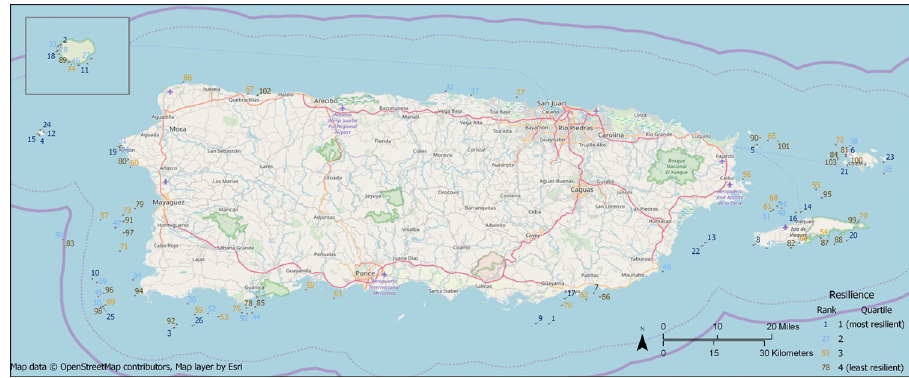
Fig 2. Survey sites (n = 103) with resilience rank scores, calculated without using the temperature variation indicator. Isla de Mona is the inset in the top left. Resilience quartiles are based on resilience scores without the temperature variation indicator.